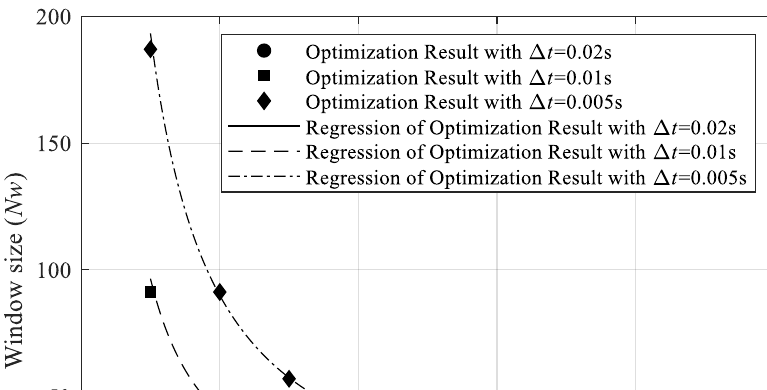
Figure 3. Ground acceleration of El Centro. Appl. Sci. 2020 , 10 , x FOR PEER REVIEW